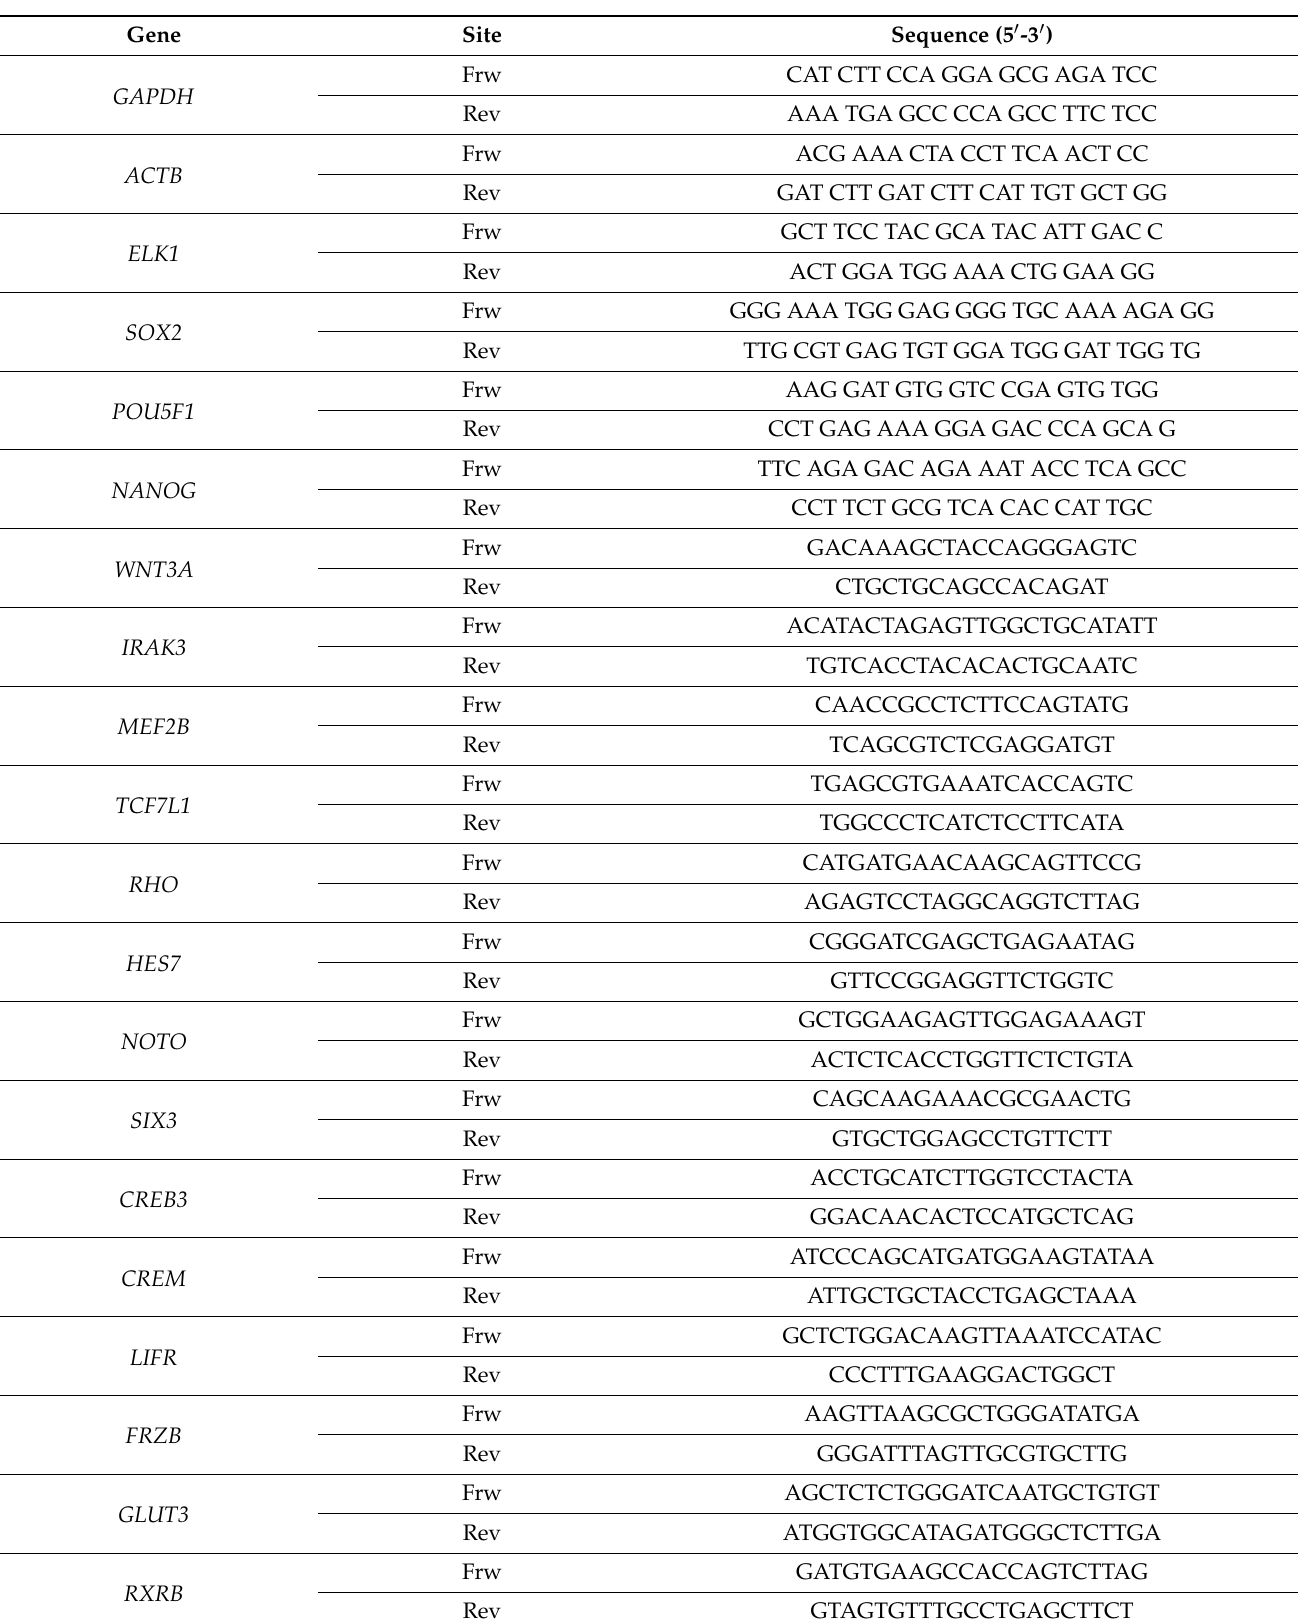
Table 1. qPCR primers